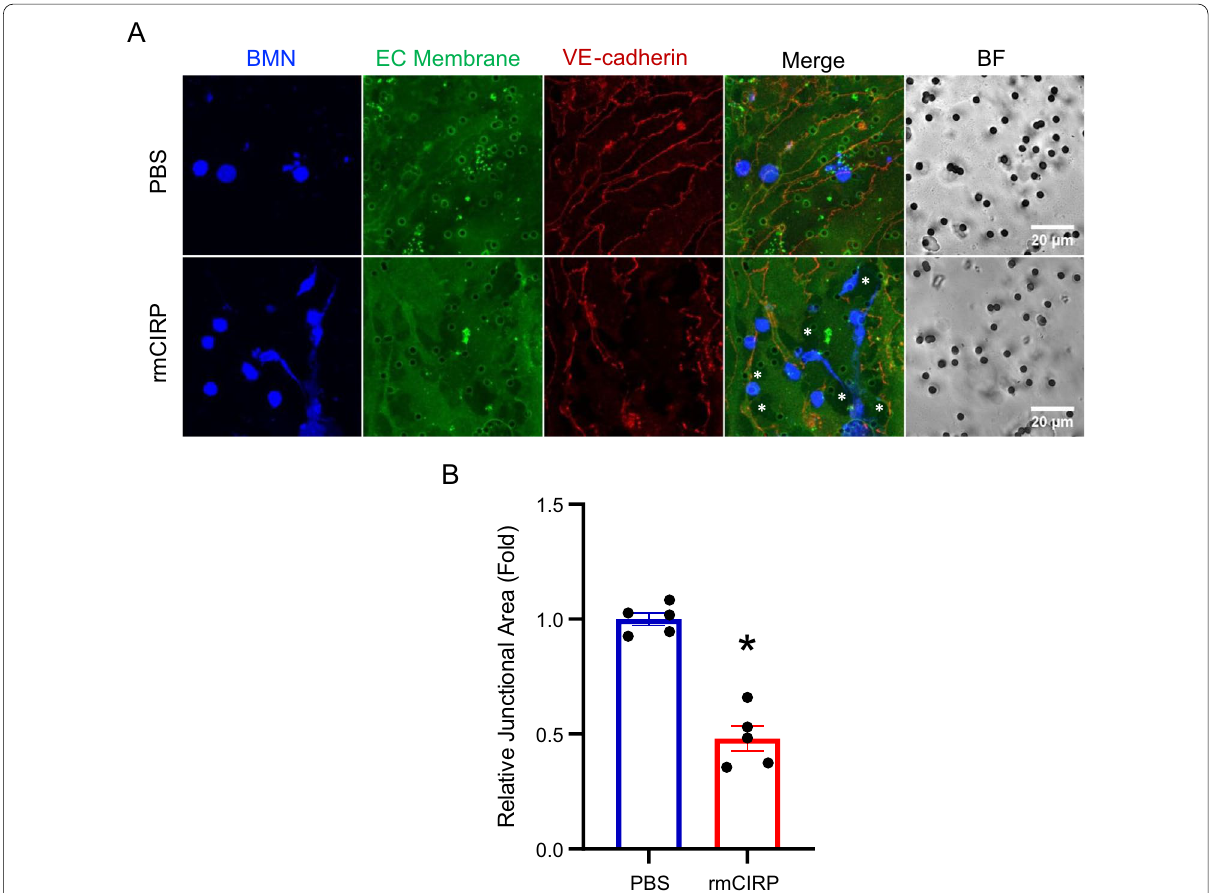
Fig. 3 eCIRP compromises cell-to-cell junctional integrity during neutrophil TEM. A The TEM assay was performed with either PBS or eCIRP (0.5 µg/ mL) for 4 h and transwell membranes were prepared to do the immunofluorescence staining. Attached neutrophils and endothelial cells were directly stained on the transwell membrane with VE-cadherin antibody (red color) and mounted onto a glass slide for microscopy. Neutrophils (BMN) were pre-stained with Celltrace Violet (blue color) prior to the assay. Endothelial cells were stained with fluorescent membrane staining dye, Membrite Green (green color) at the beginning of the TEM assay. Bright field (BF) panel of the images show the pores (black holes; 3 µm in diameter pores) of the transwell membrane. Asterisks (*) in the image for eCIRP treated indicate the regions of transwell membrane, where the endothelial cells are void due to their migration to the bottom of the transwell membrane. Scale bar, 20 µm. B The VE-cadherin immunofluorescence was further analyzed by measuring the total area of VE-cadherin in the junctions in 5 different microscopic fields. The data obtained was normalized to the level of PBS treated sample. Data represented as mean SEM. * p < 0.05, unpaired, two-tailed student’s t ±